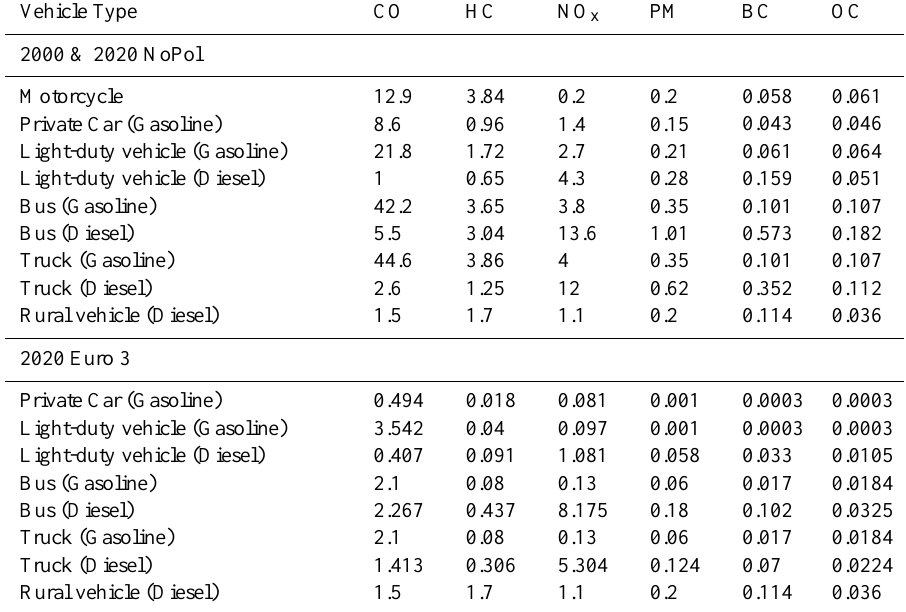
Table 3. List of Emission Factors (gkm − 1